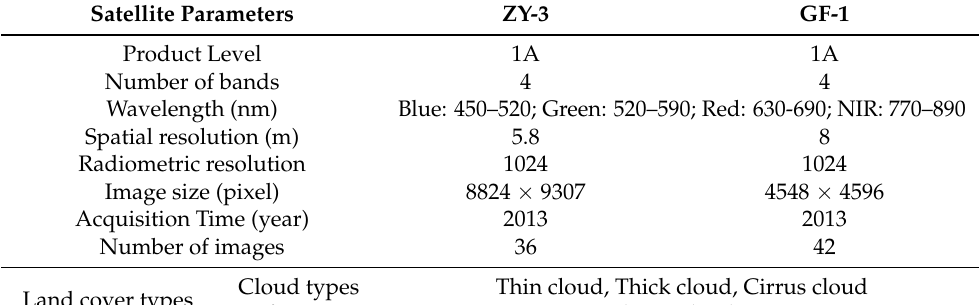
Table 2. Overview of Chinese ZY-3 and GF-1 multispectral datasets.